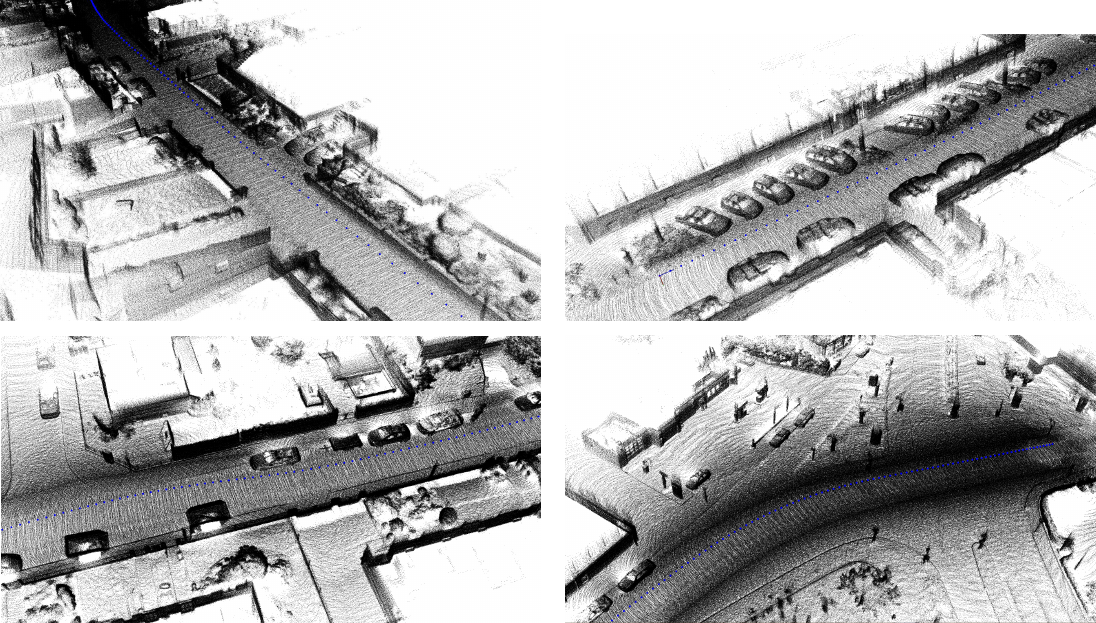
Figure 21. Results of the Kitti vision benchmark showing 3D reconstructions of the validation sequences “11”, “13”, “15” and “18” (left to right, top to bottom) for which no ground truth is